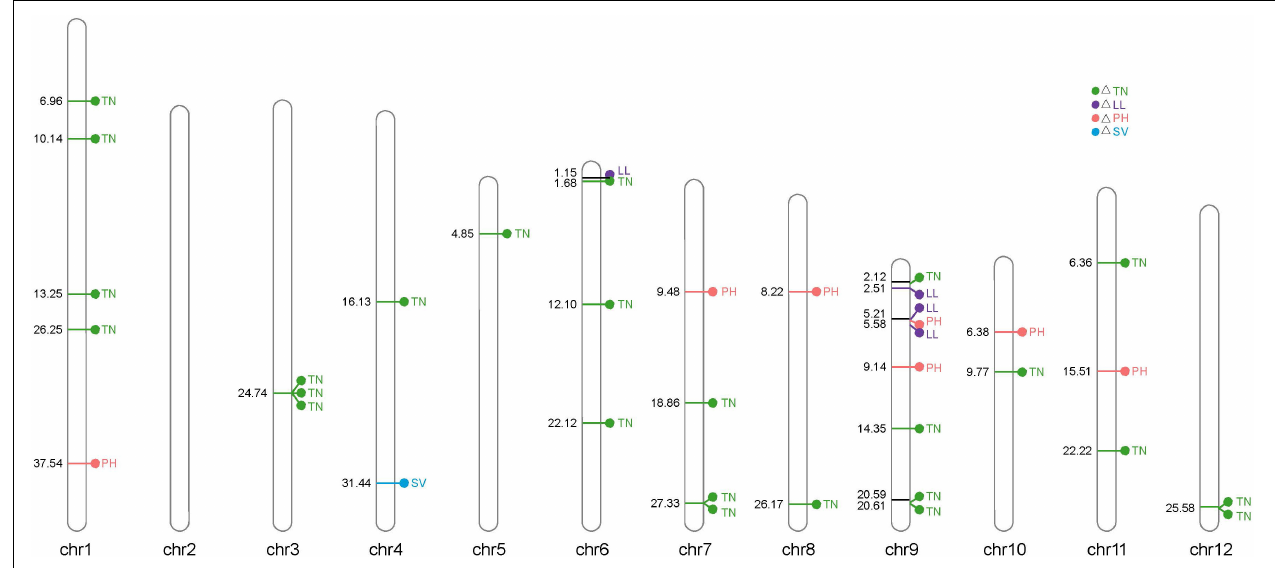
FIGURE 5 | Distribution of 56 significantly associated single-nucleotide polymorphisms (SNPs) on 12 chromosomes based on the physical distance from the four NUE-related agronomic trait differences. The numbers on the left side of each column represent the physical location (Mb) of each lead SNP. Letters to the right of each column represent the corresponding traits of (cid:77) SV, (cid:77) LL, (cid:77) PH, and (cid:77) TN. TABLE 3 | Summary of putative candidate genes for NUE.